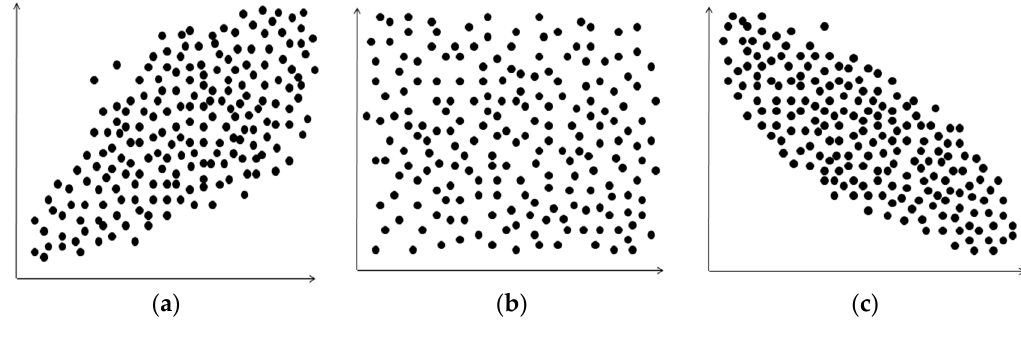
Figure 12. The synthetic dataset. ( a ) COR; ( b ) ANTI-COR; ( c ) IND.